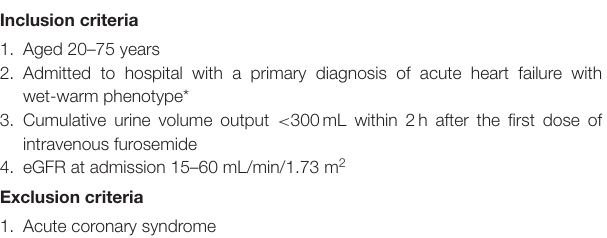
TABLE 1 | Inclusion and exclusion criteria for the diuretic resistance in acute heart failure (DR-AHF) trial. Inclusion